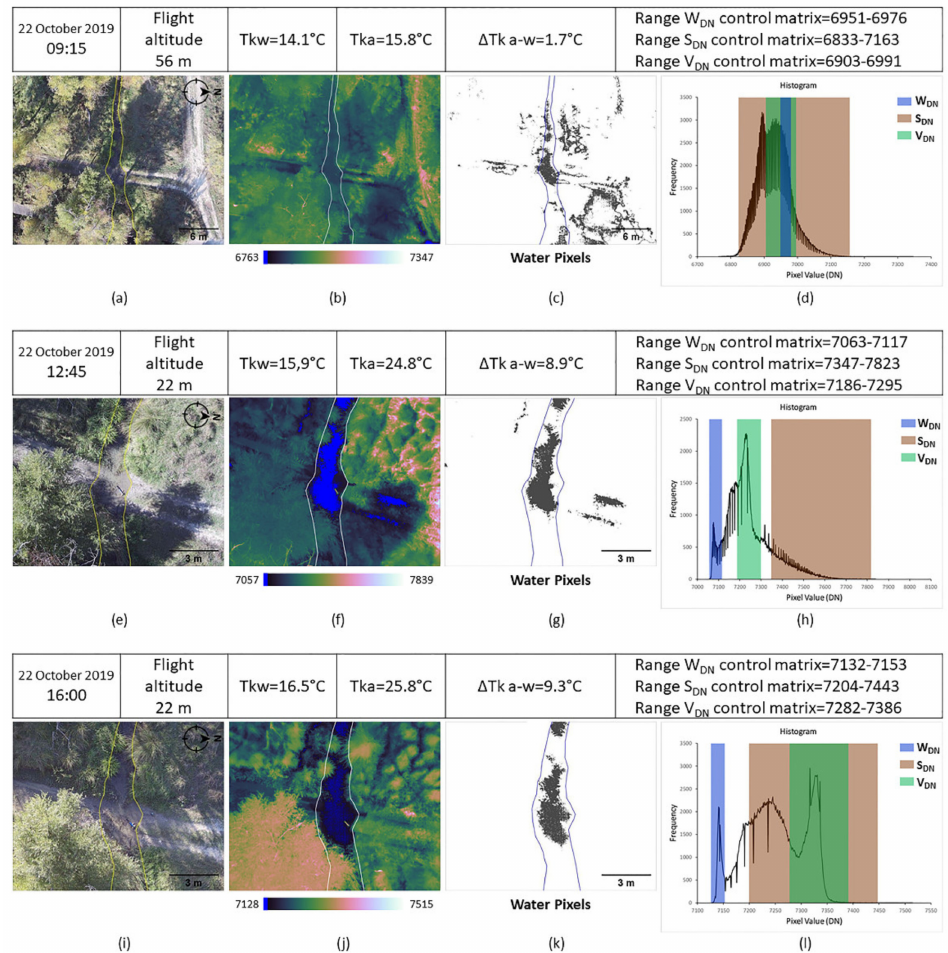
Figure 4. Surveys performed on 22 October 2019. For 09:15 ( a – d ), 12:45 ( e – h ), and 16:00 ( i – l ), the following images are shown: RGB image, with the delimitation of the geomorphic channel ( a , e , i ); the corresponding IR thermal image in false color, with the delimitation of the geomorphic channel ( b , f , j ); the pixels within the W DN range ( c , g , k ); the frequency distributions of the DN values of the thermal images, with three bands highlighting the W DN , S DN, and V DN ranges ( d , h , l ). Furthermore, information is provided about the date, time, and height of the flight; Tka, Tkw, and ∆ Tk a–w; and minimum and maximum values of the W DN , S DN, and V DN ranges. Images of all the flights performed during this day are provided in the Supplementary